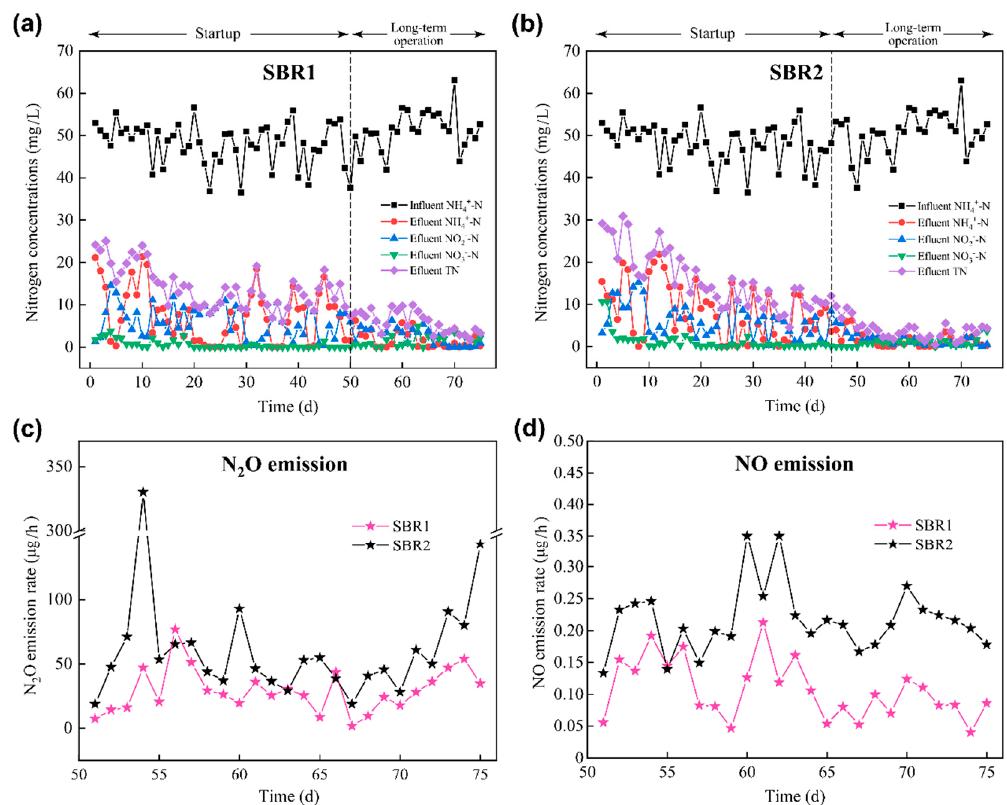
Figure 1. Daily monitored nitrogen removal performances ( a , b ) and gas emissions ( c , d ) of both sequencing batch reactors (SBRs) during the startup and long-term operation period. The nitrous oxide (N 2 O) and nitric oxide (NO) generation rates were profiled since the 50 d after the startup.